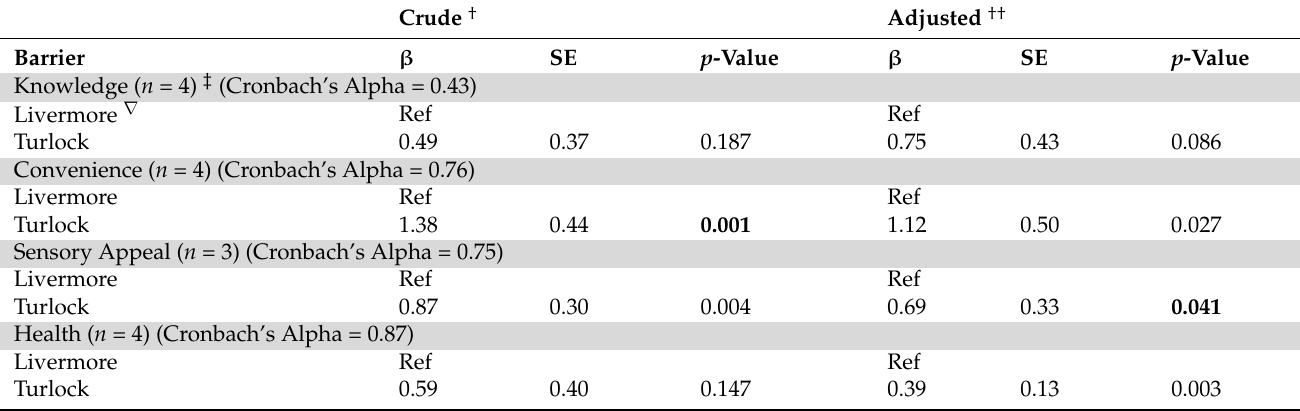
Table 3. Crude and adjusted linear analysis of perceived MD barriers.